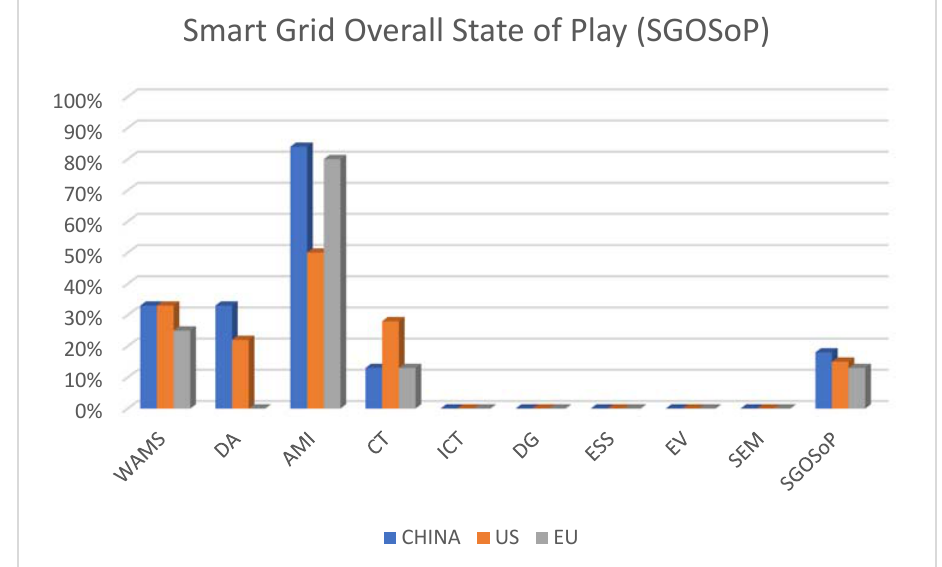
Figure 2. Smart grid overall state of play (SGOSoP) within China, the US, and the EU.